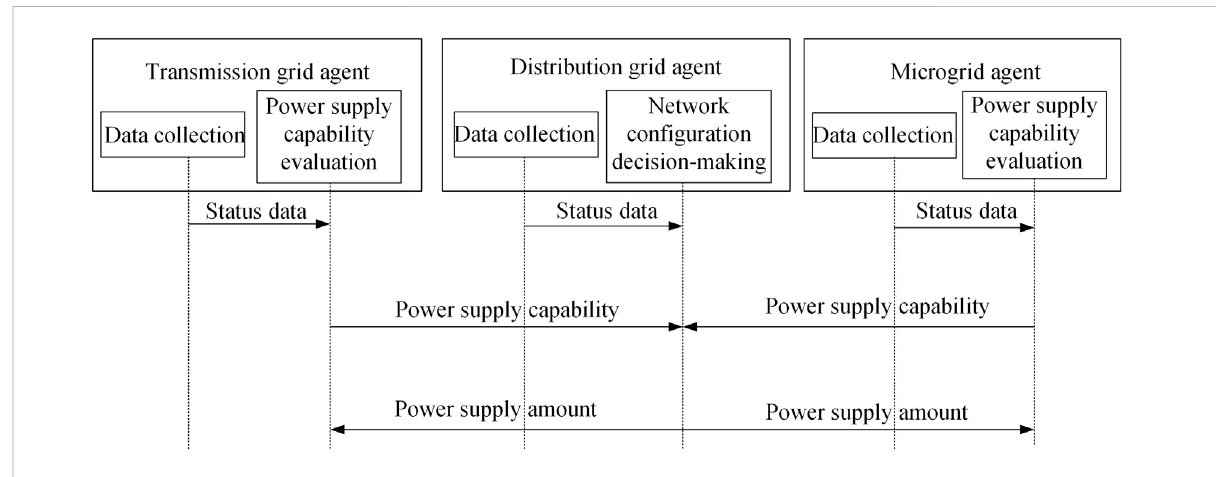
FIGURE 2 Interaction process among agents for substation load restoration in one